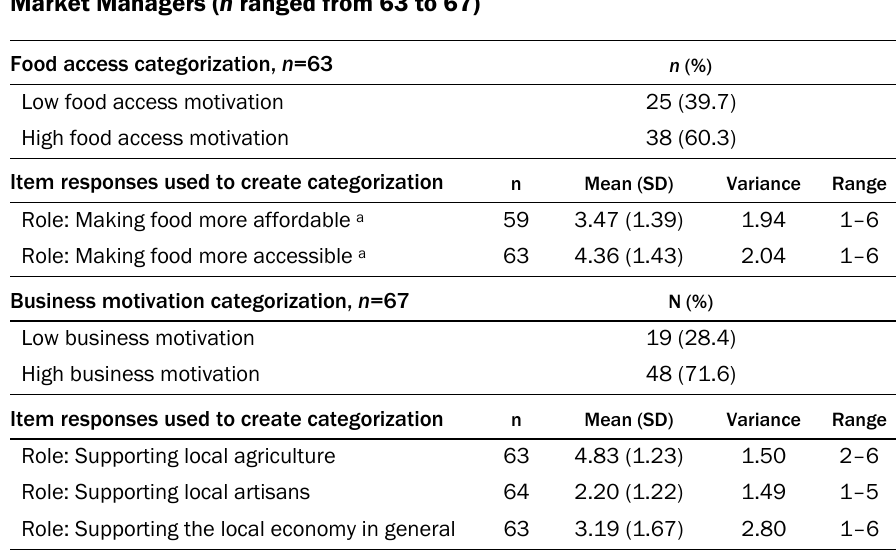
Table 1. Distribution of Survey Items Used To Create Binary Food Access and Business Motivation Categorization Among North Carolina Farmers Market Managers ( n ranged from 63 to